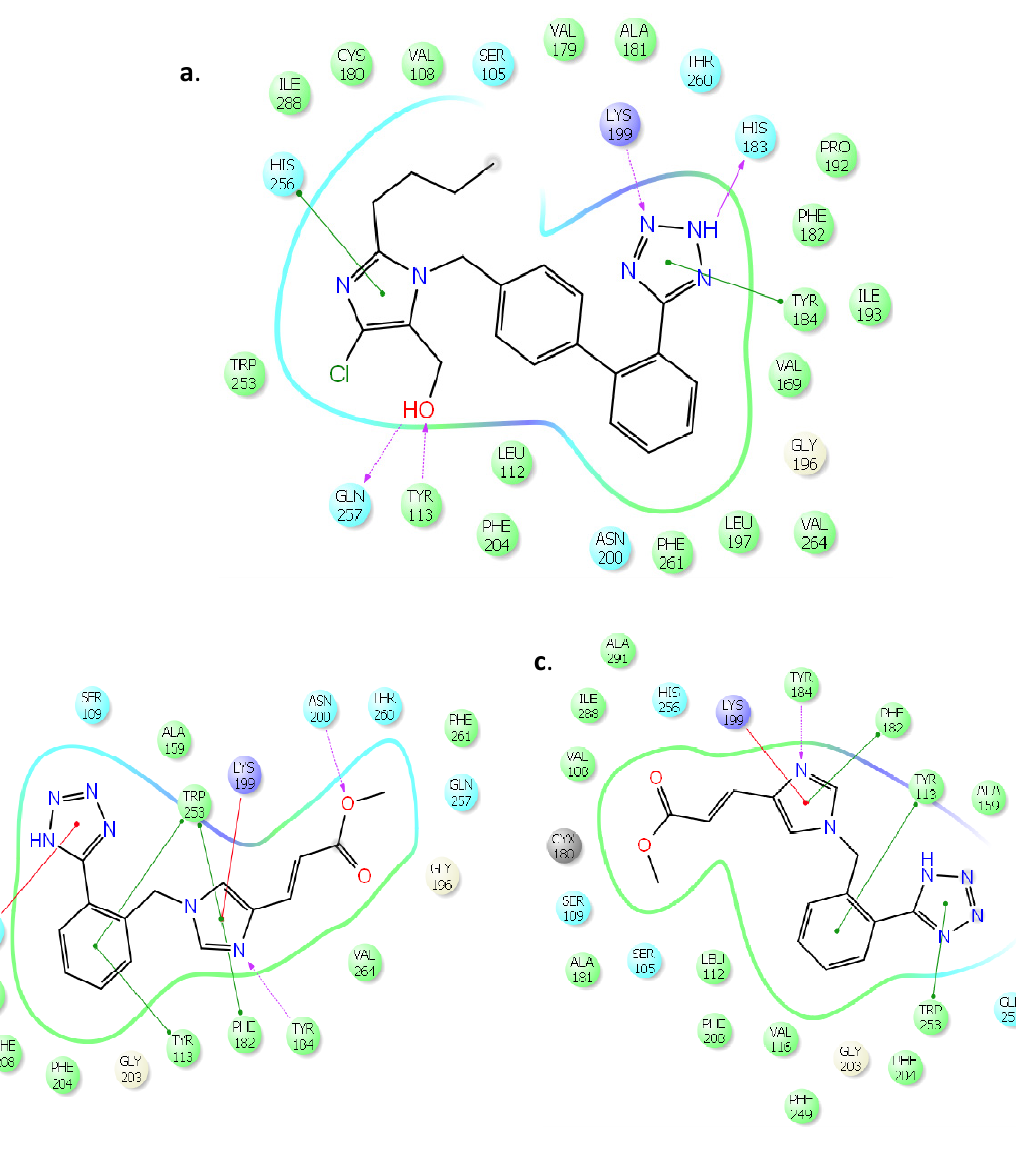
Figure 1. Ligand interactions of a losartan; b and c analogue 12 ; d and e analogue 18 with the aminoacids of the active site of AT1; ( b and d represent orientations of analogues 12 and 18 with the highest scoring and c and e. represent orientations with low